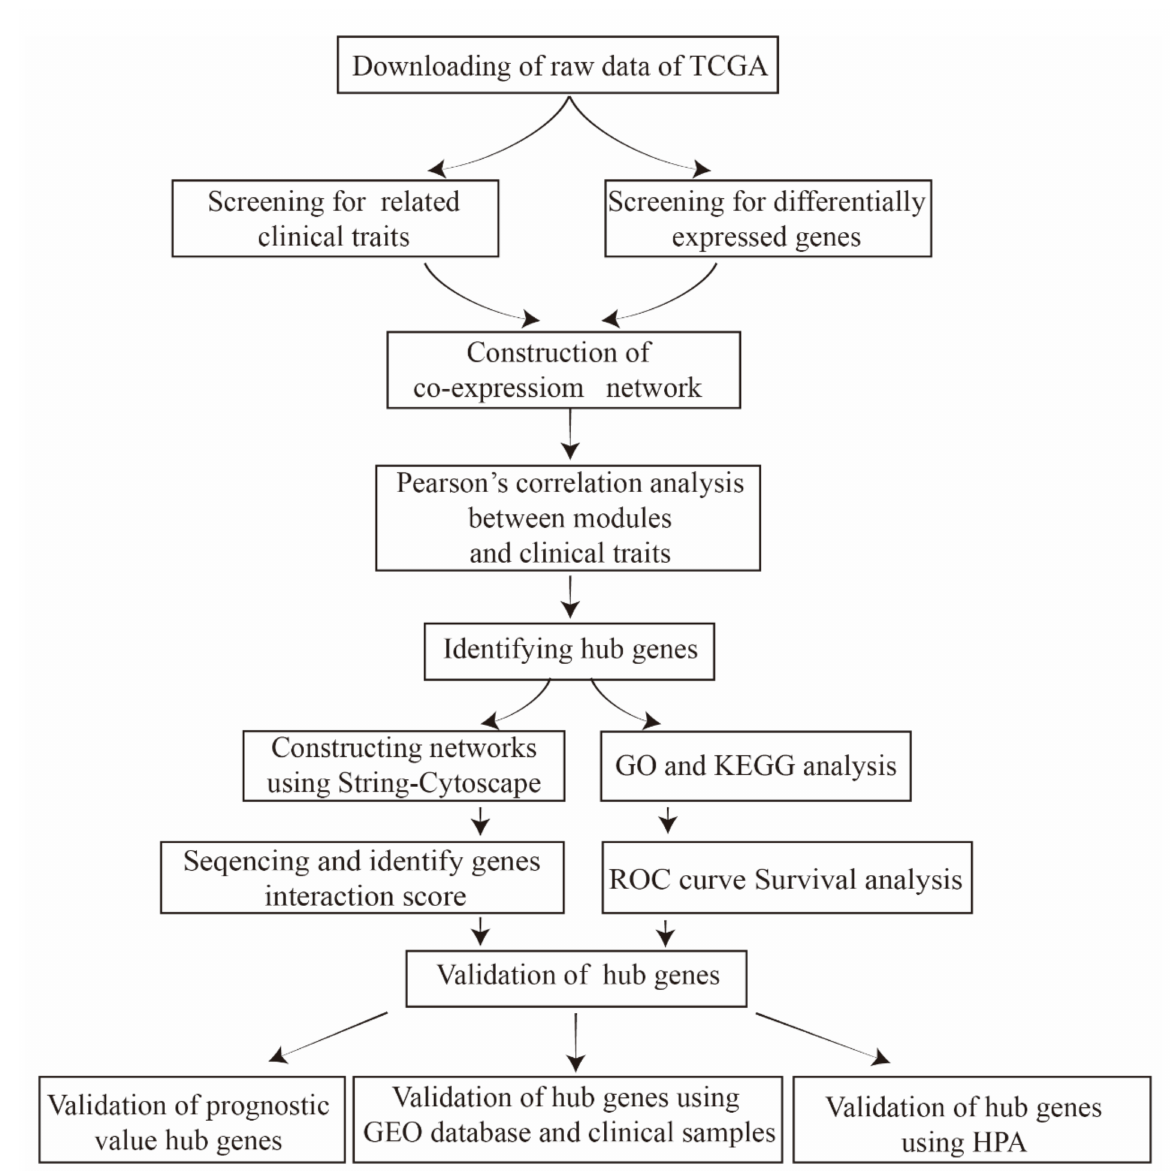
Figure 1. Flowchart of data collection and